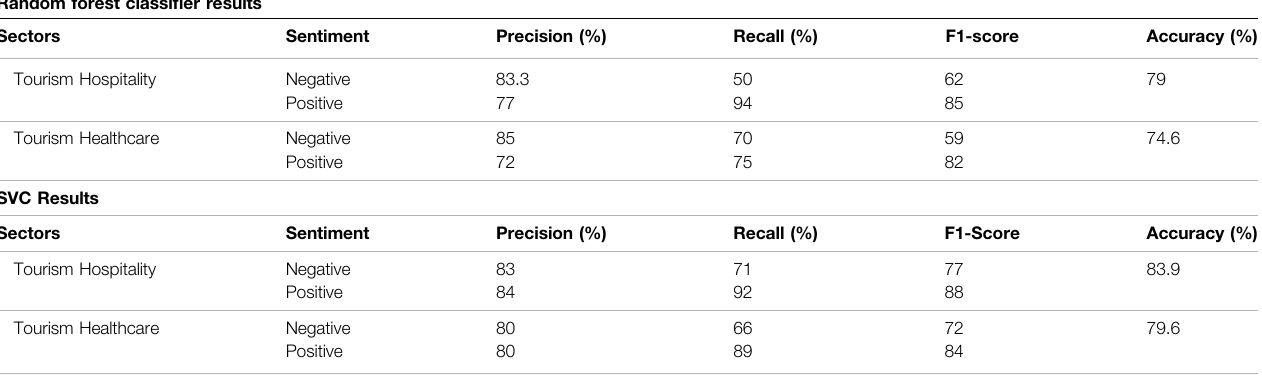
TABLE 2 | Comparison of machine learning models.